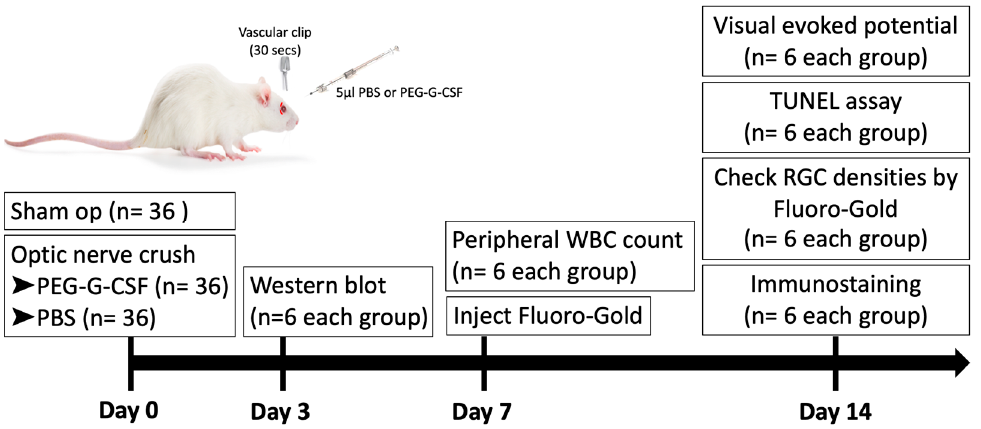
Figure 1. Brief summary of study design to investigate the role of intravitreal injection (IVI) of pegylated granulocyte colony-stimulating factor (PEG-G-CSF) in the rat optic nerve crush (ONC) model. PBS: phosphate-buffered saline. RGC: retinal ganglion cell. WBC: white blood cell.